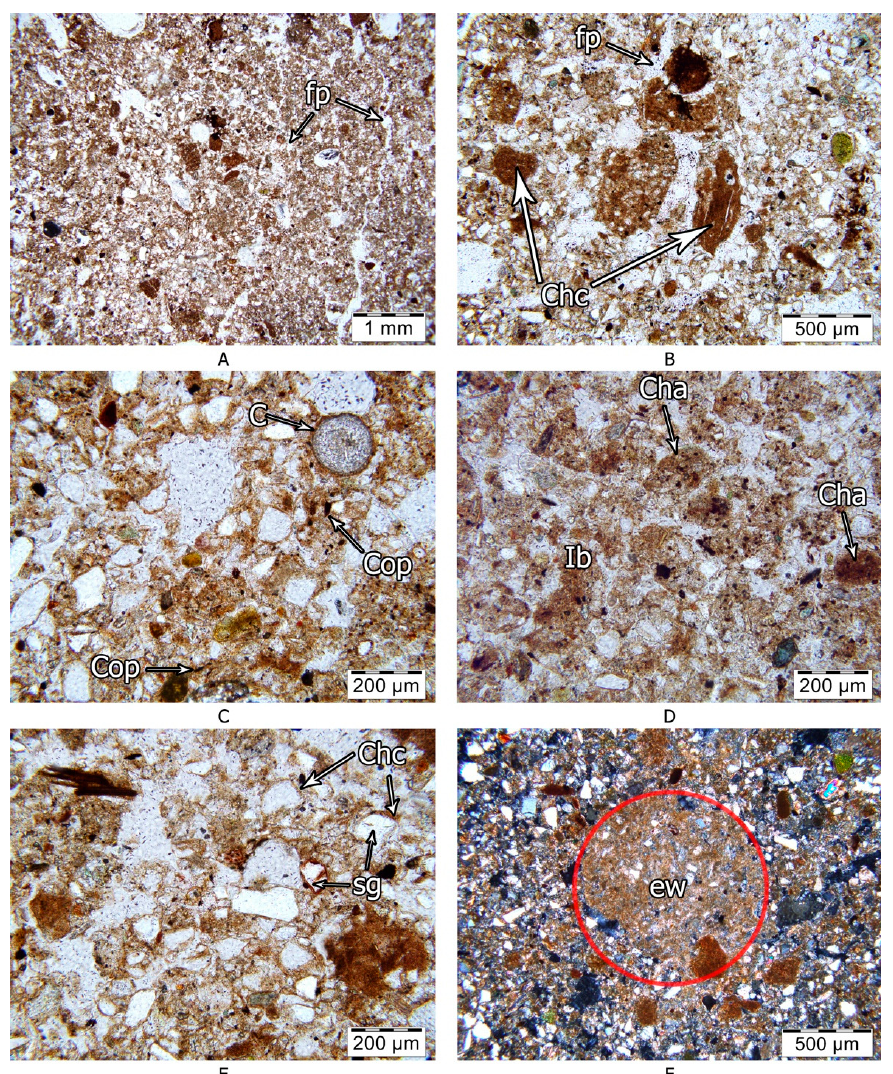
Figure 7. The microstructure of the lower part of the loess layer (80–100 cm): ( A )–silty material with abundant fine pores (fp) and granular microstructure. Note abundant fragments of Chocolate clays of fine sand and coarse silt size. PPL; ( B )–the same with higher magnification. Note clay fragments (Chc) of various shapes, colors, and grain sizes, and the presence of glauconitic grains, PPL; ( С )–spore covered by clay coatings ( C ) and abundant coal particles (Cop), PPL; ( D )–clay-humus aggregates(Cha) and colonies of iron bacteria(Ib), PPL; ( E )–clay-humus coatings (Chc) on sand grains (sg), PPL; ( F )–earth-worm (ew) cast filled with carbonate material of Chocolate clay, XPL.